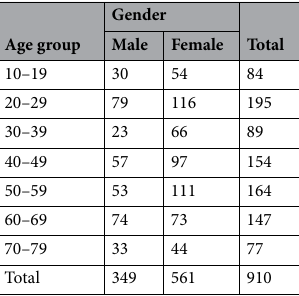
Table 1. Age and gender distribution of dental x-ray